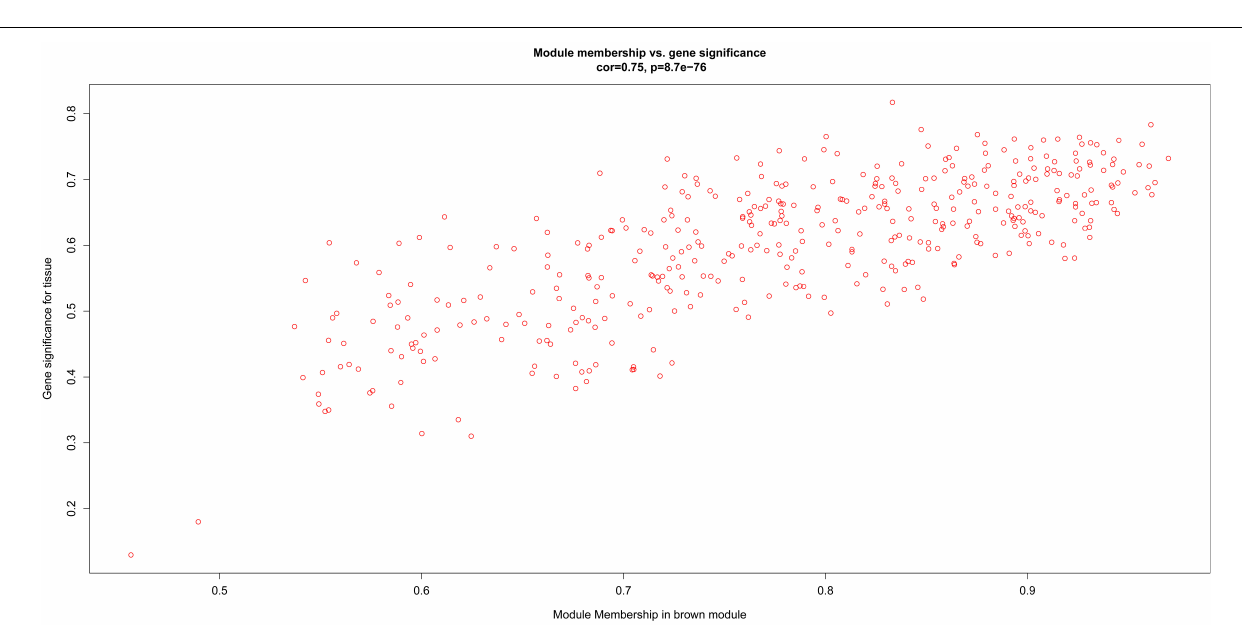
Frontiers in Physiology |